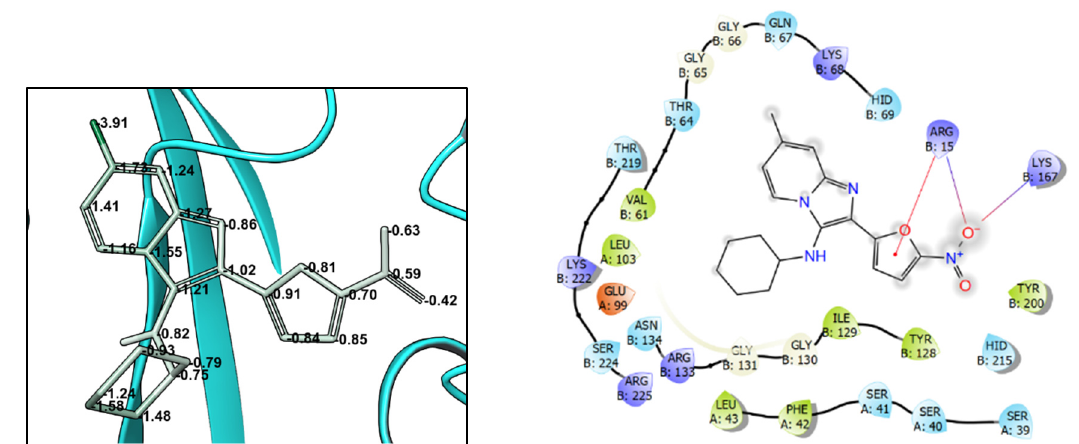
Figure 5. Strain energies and interaction diagrams of compounds 4a ( A ), 4b ( B ), 4c ( C ), and 4d ( D ) that were docked into the structure of oxygen-insensitive NADPH nitroreductase NsfA (PDB 7NB9) using the flexible docking protocol.